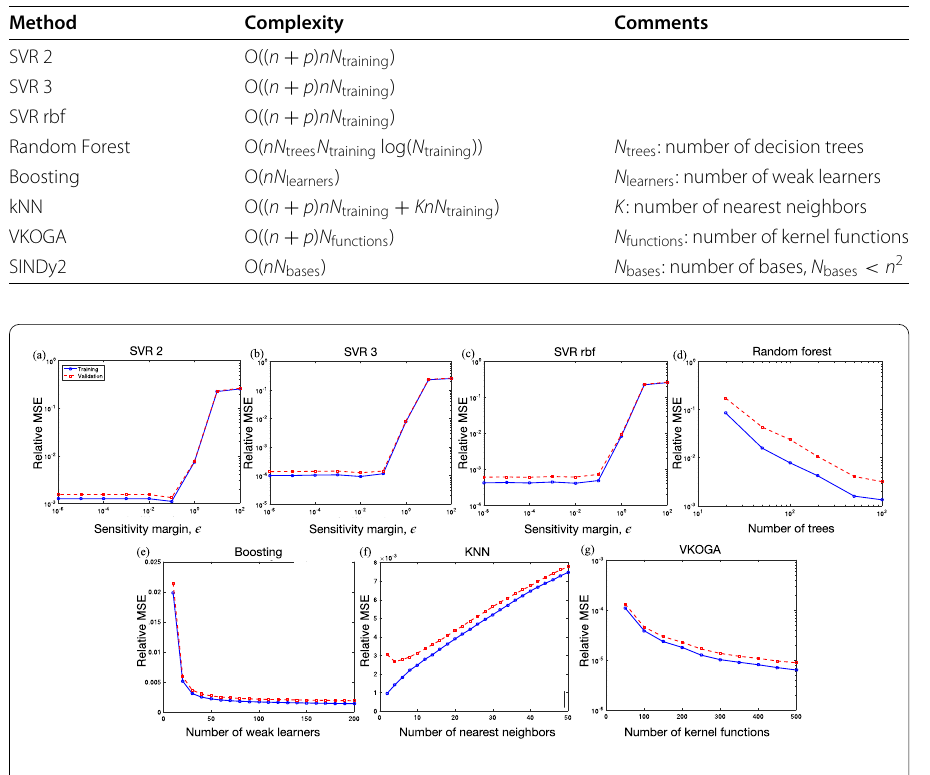
Fig. 12 Hyperparameter selection for all considered regression models. Relative mean squared errors are reported: a SVR2, b SVR3, c SVR rbf, d random forest, e boosting, f kNN, g VKOGA. The training and validation set correspond to the default size: N training = 1000 and N validation = 500. Blue curves represent training errors and red curves represent validation